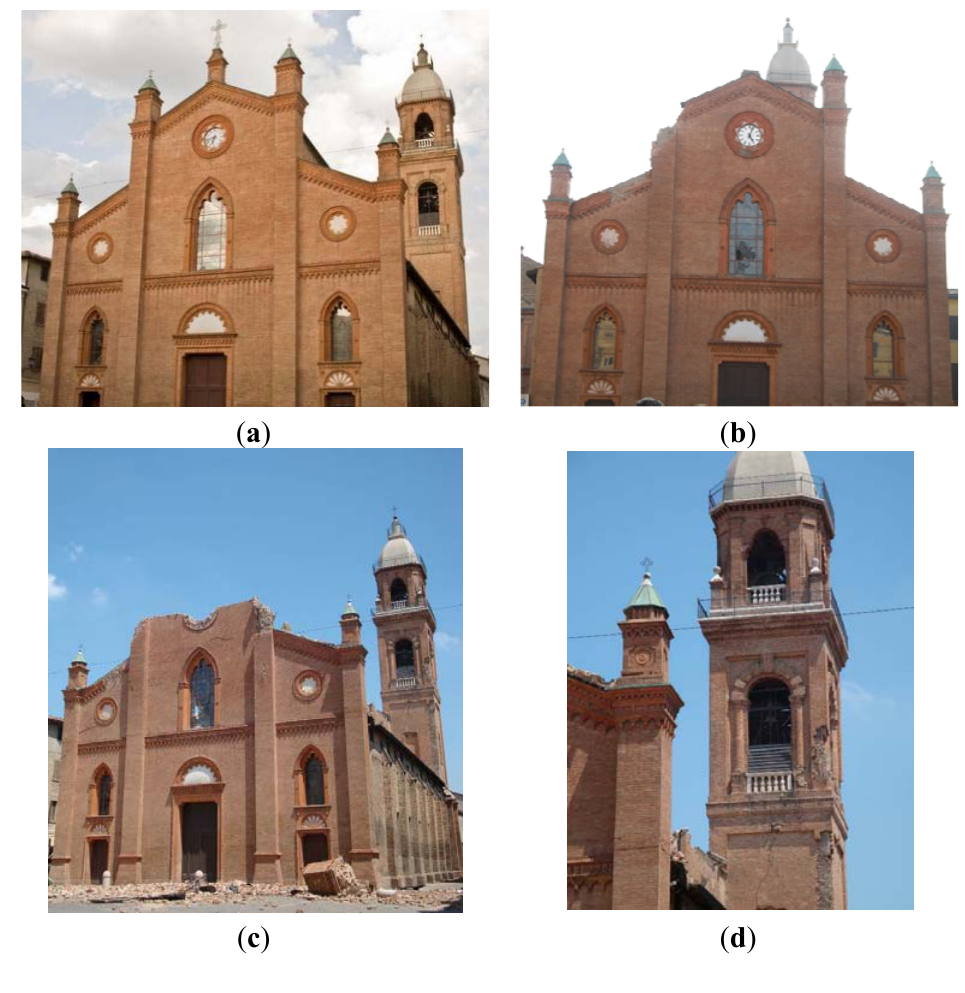
Figure 23. Cathedral of Santa Maria Maggiore in Mirandola: ( a ) Overall view before the 2012 Emilia Romagna earthquakes; ( b ) Main façade after the 20 May 2012 earthquake; ( c ) Overall view after the 29 May 2012 earthquake; ( d ) Large diagonal cracks in the bell